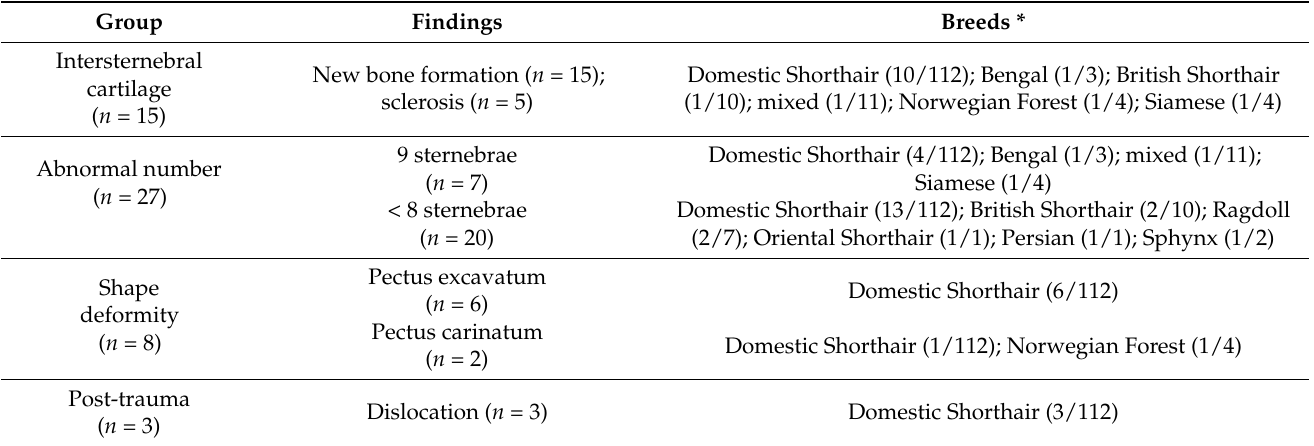
Table 2. Radiographic findings and breeds per category of sternal abnormality in